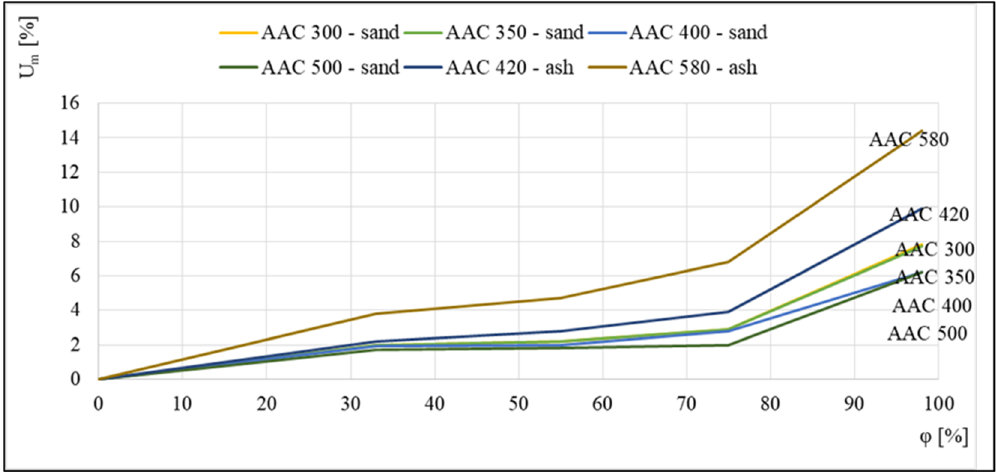
Figure 5. Sorption isotherms of 300, 350, 400, and 500 kg/m 3 sand-based aerated concretes and 420 and 580 kg/m 3 ash-based aerated concretes, based on [17].